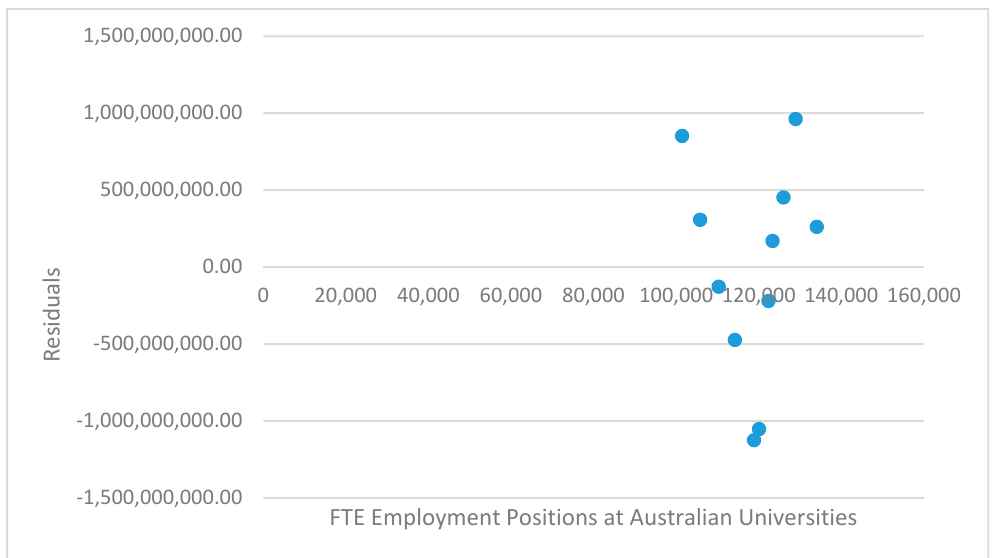
Figure 2. Residual Plot for International Student Enrolments and Total Australian University Revenue.